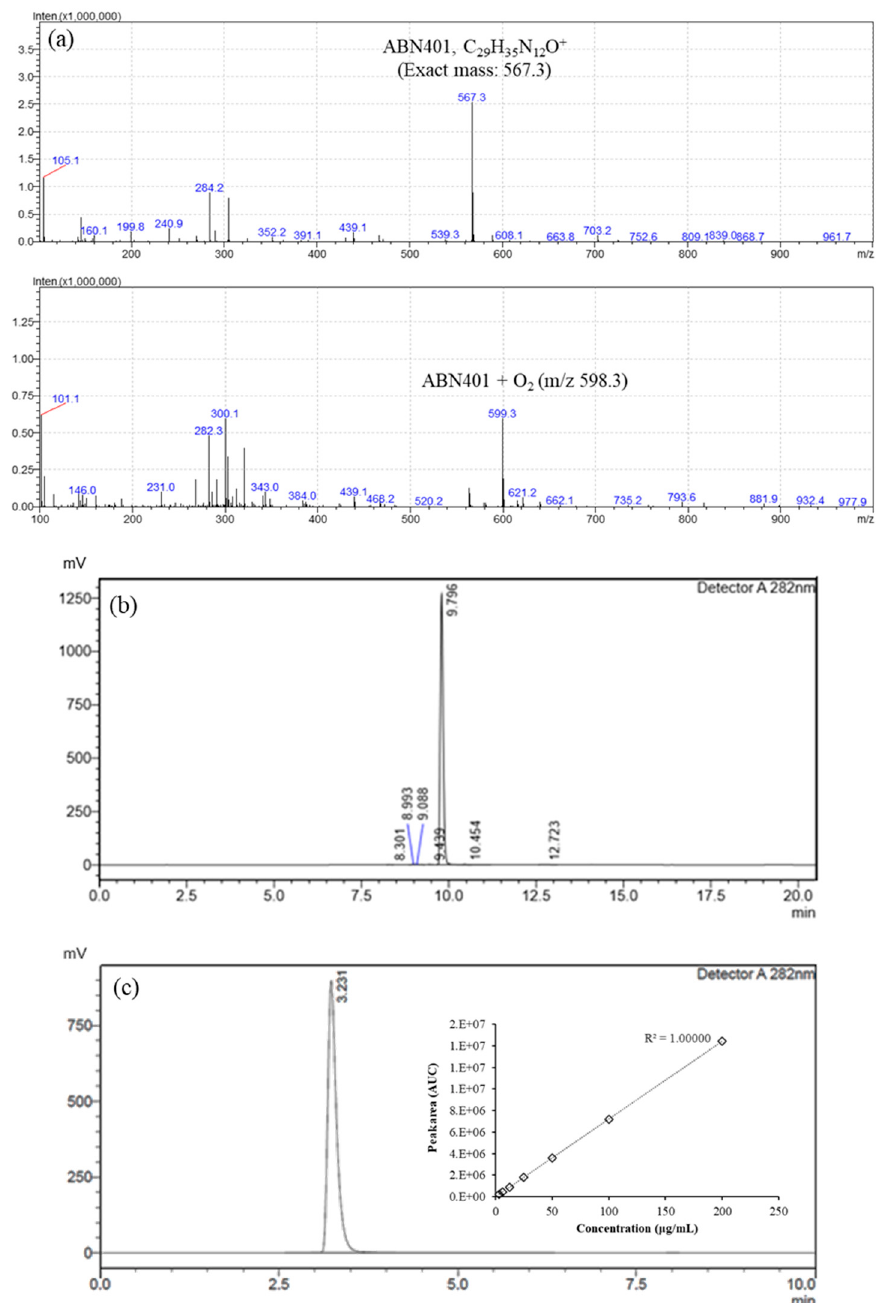
Figure 2 . Determination of molecular weight of ( a ) ABN401 and addition of hydrogen peroxide using LC-MS, and HPLC result for ABN401 using ( b ) a qualification method (seven peaks) and ( c ) a quantification method (one peak) with linearity curve (R 2 = 1) depending on concentration.